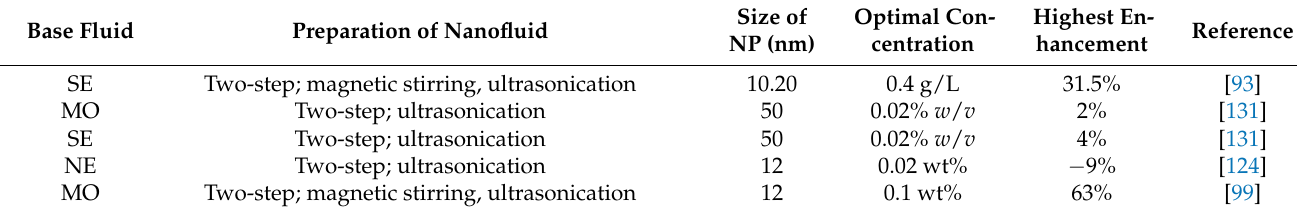
Table 8. SiO 2 AC-BDV overview table. The size of NP refers to the nanoparticle core size, while the optimal concentration indicates the concentration value for which the maximal enhancement of AC-BDV was found. Base